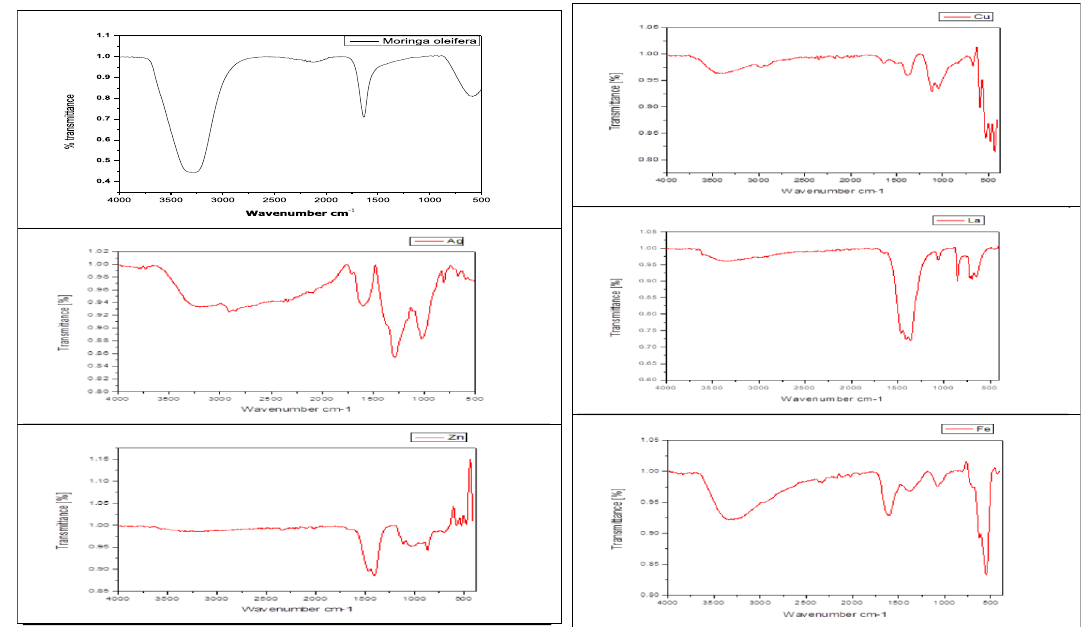
Figure 2. FTIR spectrum of biosynthesized nanoparticles from M. oleifera.